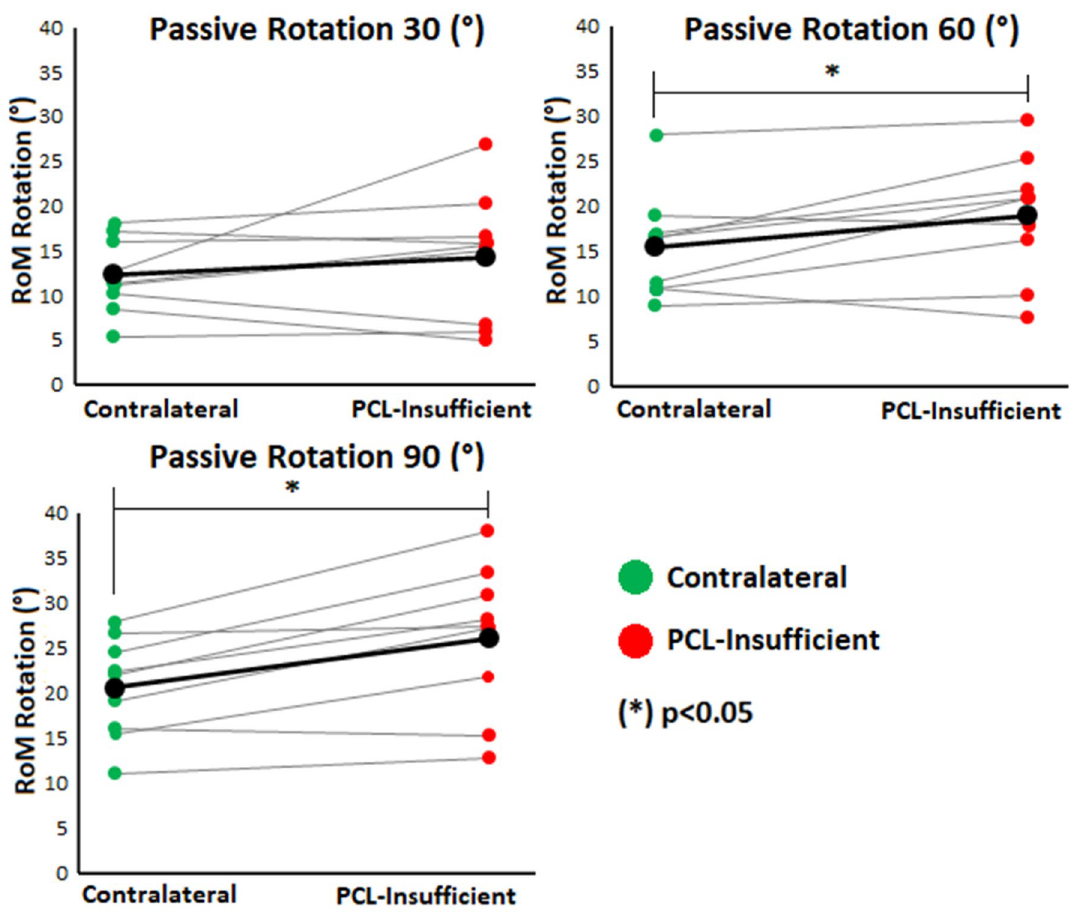
Figure 3. Passive rotational range of motion (RoM) of each knee joint at 30, 60 and 90° knee